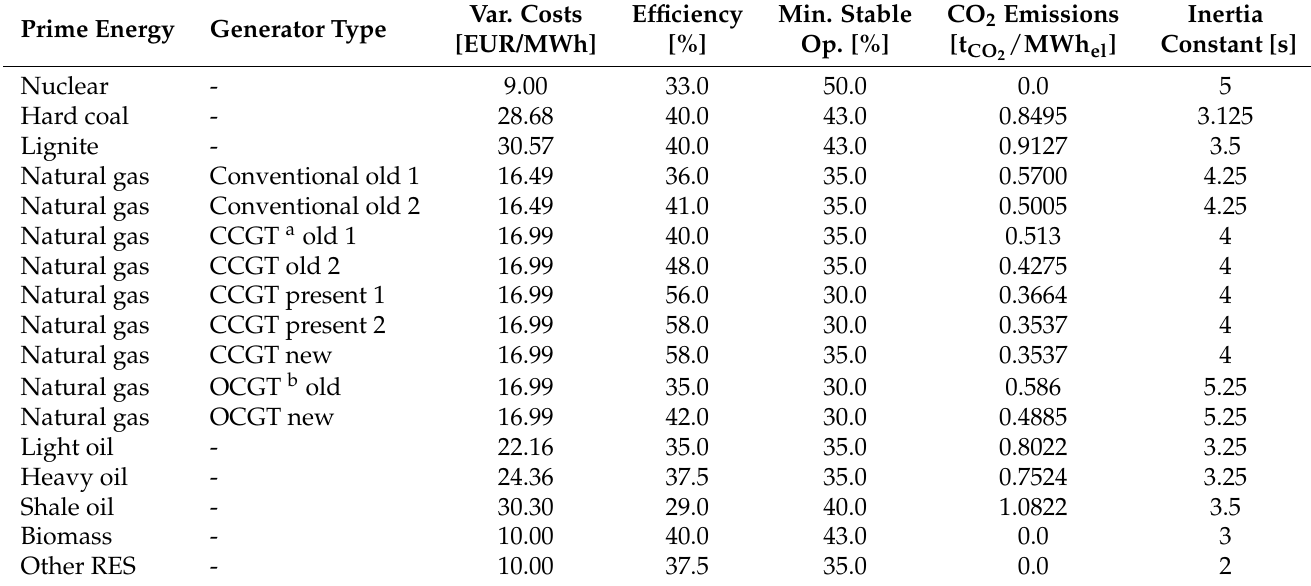
Table 2. Generator characteristics. Data from [20,51–58].